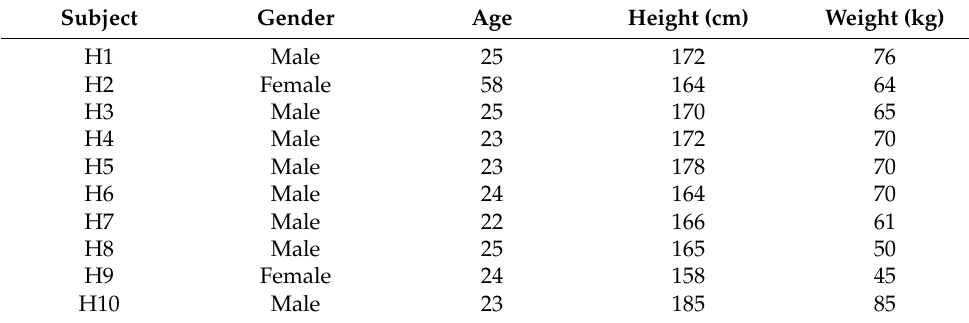
Table 3. Information of the healthy subjects.